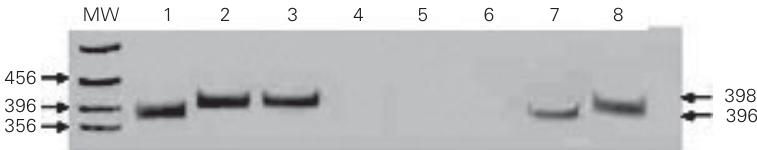
Figure 1. Analysis of constitutive CYP2A3 mRNA expression (398-bp product) by RT-PCR in different rat tissues. Lanes : 1 , Liver; 2 , lung; 3 , esophagus; 4 , kidney; 5 , proximal intestine; 6 , middle intestine; 7 , distal intestine; 8 , nasal epithelium. MW, molecular weight standard (pBluescript SK+ digested with Hin fI; Stratagene, La Jolla, CA, USA) . The 396-bp product corresponds to CYP2A1/CYP2A2 mRNA.